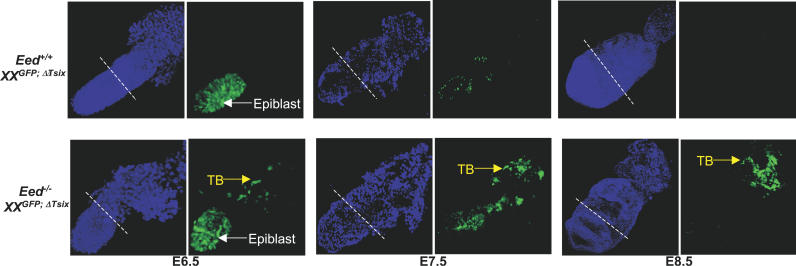
Lack of Defects in Random XCI in Post–Implantation Stage Eed
−/− EmbryosBoth WT and Eed
−/− embryos contain on their Xp a GFP transgene and a mutation in the Tsix gene (XXGFP;
ΔTsix and XXGFP;
ΔTsix; Eed
−/−, respectively). The extraembryonic ectoderm (ExE) and its derivatives maintain imprinted XCI of the Xp that is established in all cells of the preimplantation embryo, while the embryonic epiblast lineage undergoes erasure of the imprint at the late blastocyst stage resulting in reactivation of the Xp. This is then followed by random inactivation of either the paternal or maternal X-chromosome during postimplantation development.The Tsix mutation on the paternal X-chromosome results in its preferential inactivation in the epiblast. GFP fluorescence in the epiblast or epiblast derivatives of E6.5 and E7.5 embryos is due to residual Xp activity after its reactivation at the late blastocyst stage. By E8.5 when random XCI is complete, epiblast derivatives of both XXGFP;
ΔTsix and XXGFP;
ΔTsix; Eed
−/− embryos lack expression of the Xp-GFP transgene, indicating that Eed is not required for the maintenance of random XCI. Dashed lines delineate border between embryonic and extraembryonic compartments of the embryo; TB, trophoblast cells.
XXGFP;
ΔTsix embryos exhibit a complete absence of Xp-GFP fluorescence in the extraembryonic compartment. XXGFP;
ΔTsix; Eed
−/− embryos, however, harbor increasing numbers of GFP-expressing trophoblast cells, indicating that Tsix is not required for reactivation of the Xp.